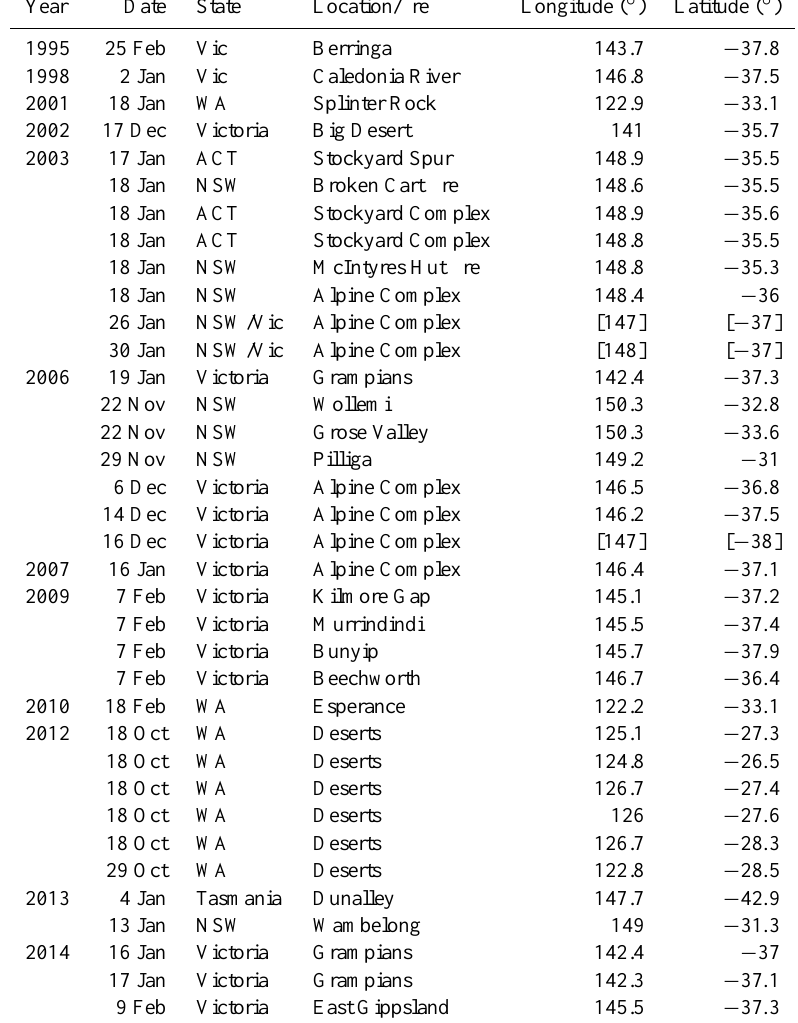
Table A1. List of events in Australia which, based on available evidence, are known to have been, or are strongly suspected to have been, pyroCb occurrences.